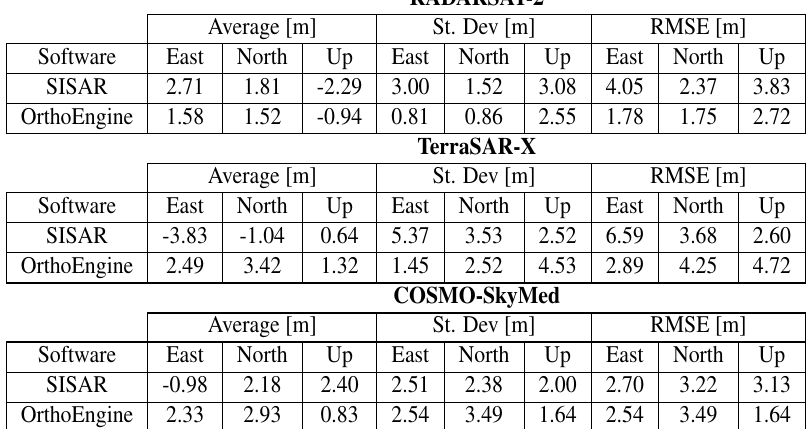
Table 2: Beauport test site model